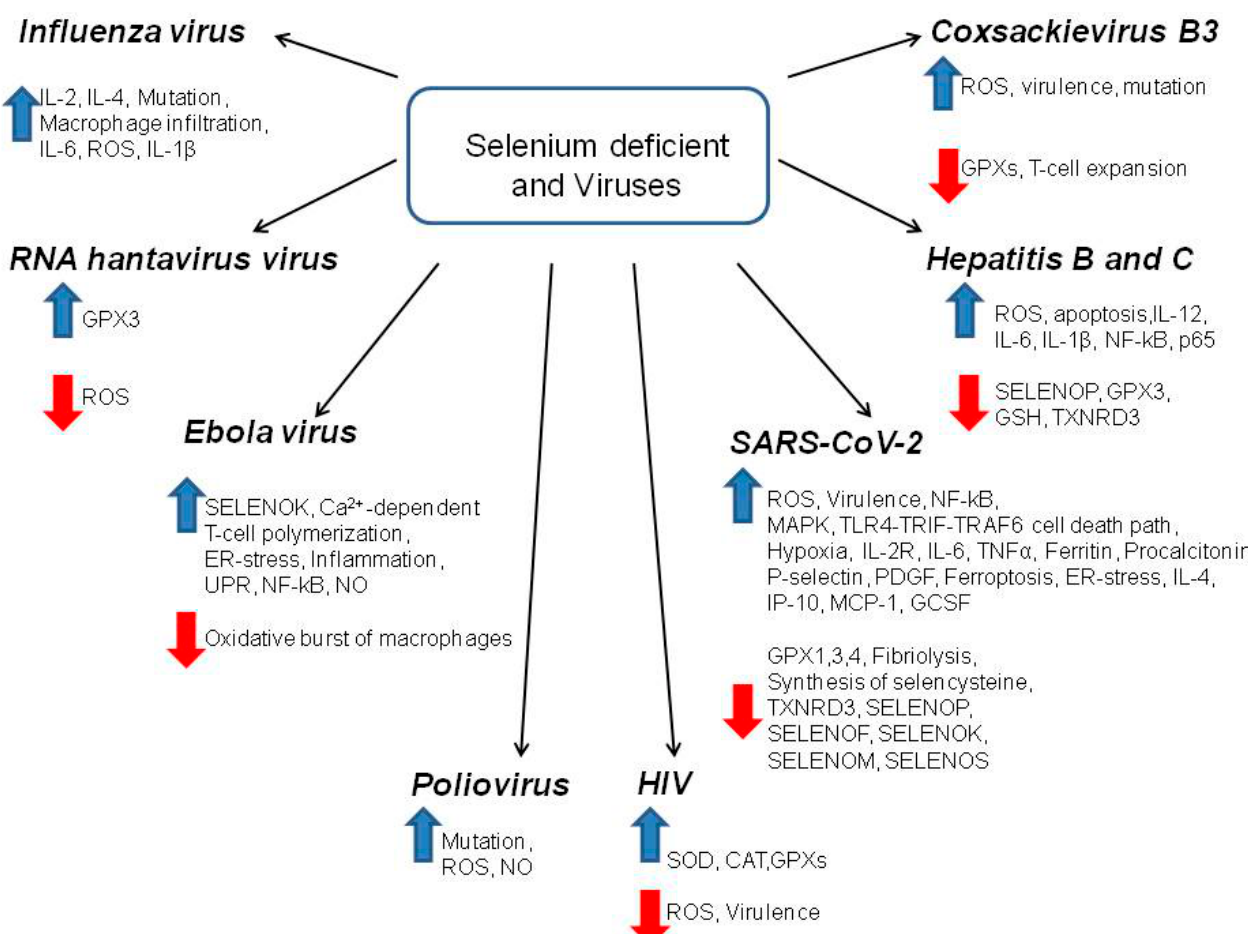
Figure 6. The relationship of Se deficiency with the mechanisms and pathogenicity of viral infections. IL-2, 4, 6, 12—interleukins -2, 4, 6, 12; IL-1 β —interleukin-1 beta; ROS—reactive oxygen species; GPX1, 3, 4—glutathione peroxidases 1, 3, 4; SELENOK, SELENOF, SELENOM, SELENOS,